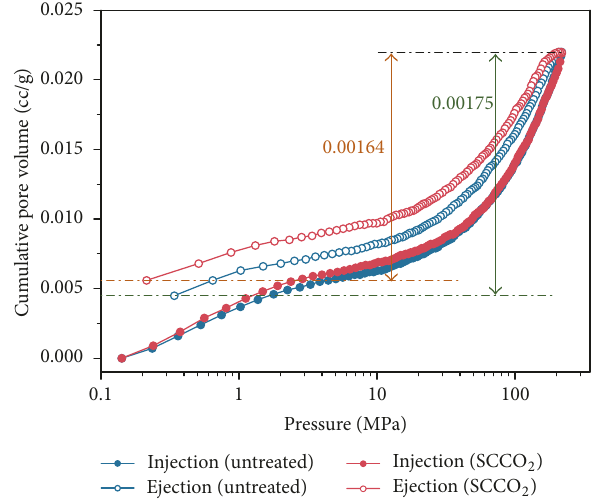
Figure 7: Changes in cumulative pore volume as a function of pressure for oil shale before and after SCCO 2 treatment by applying